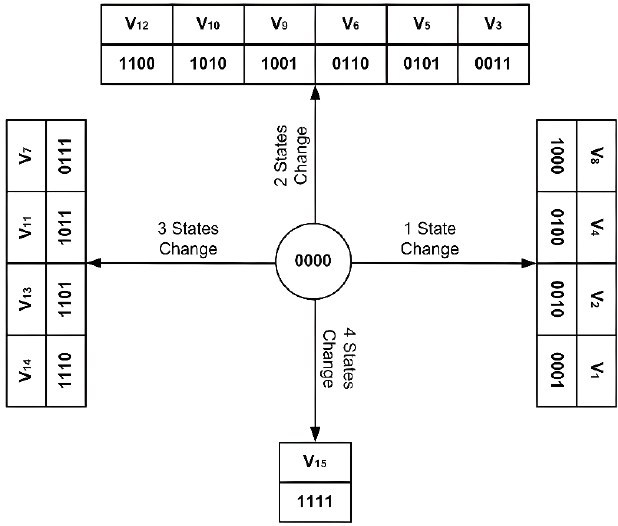
Figure 2. TP4LI Switch-State Changes.